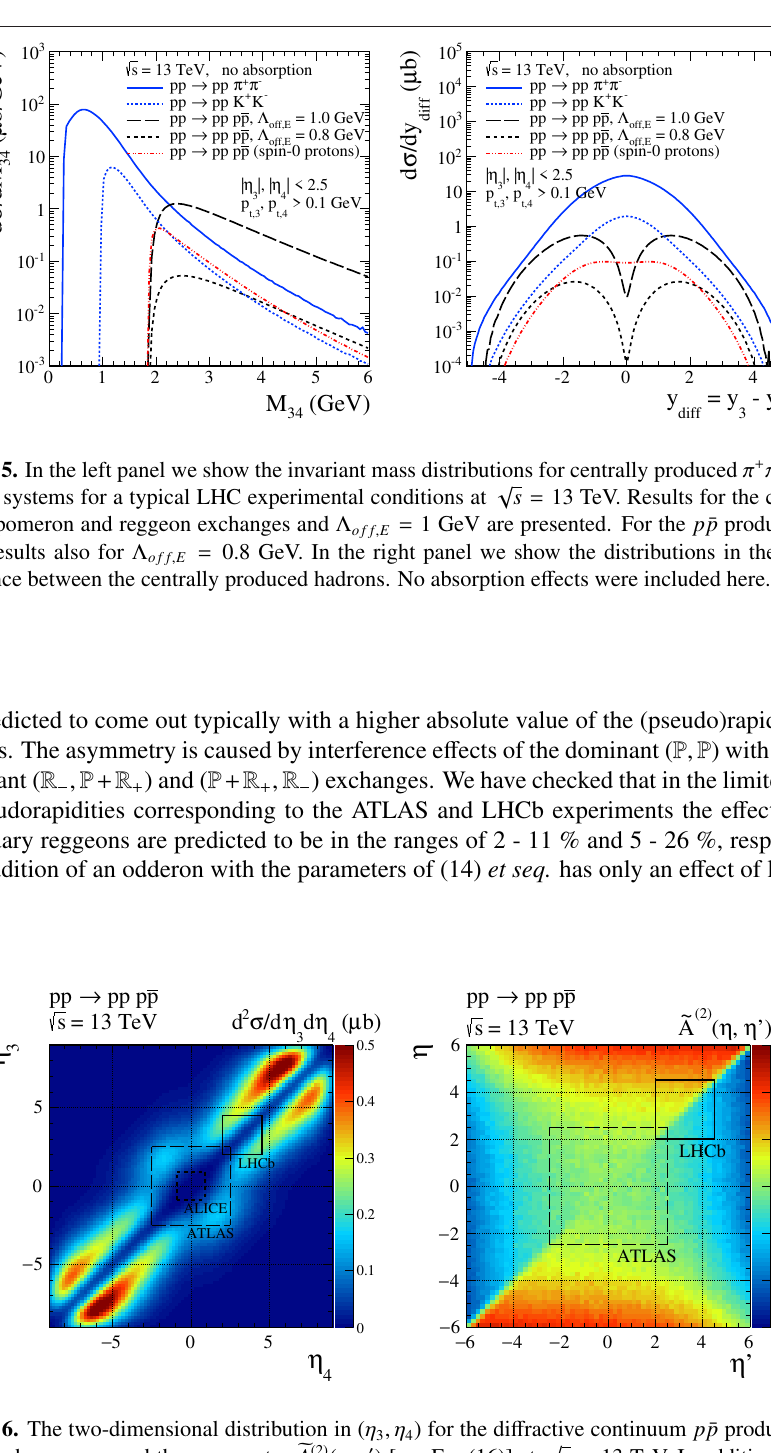
√ s = 13 TeV. In addition, regions